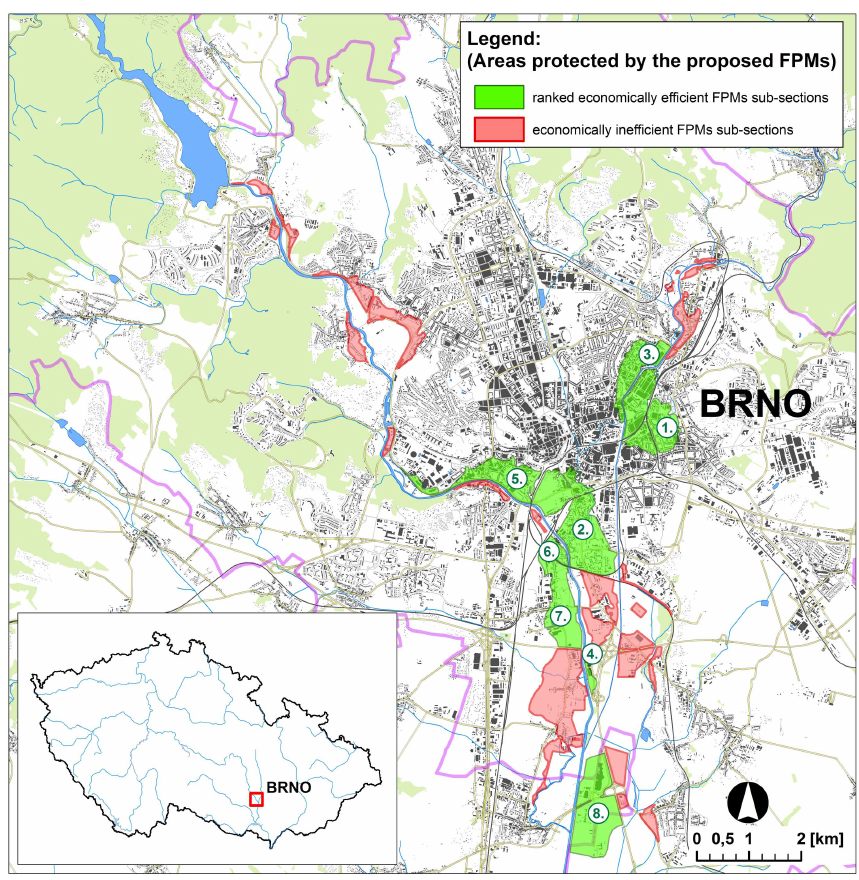
Fig. 8. Layout plan with ranked FPMs sub-sections in the city of Brno. Labels mean order of the corresponding FPM according the